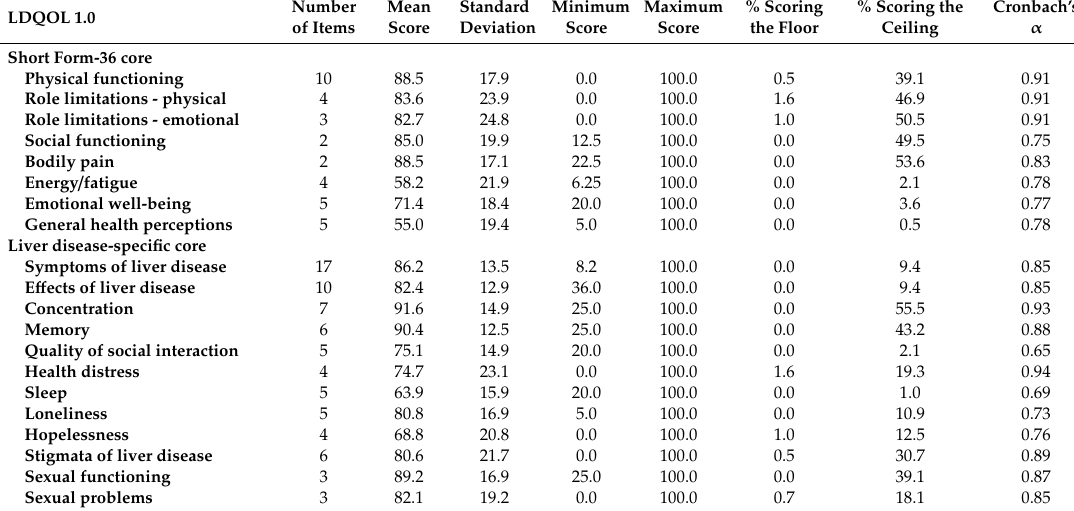
Table 2. Baseline descriptive statistics and internal consistency of the Korean LDQOL